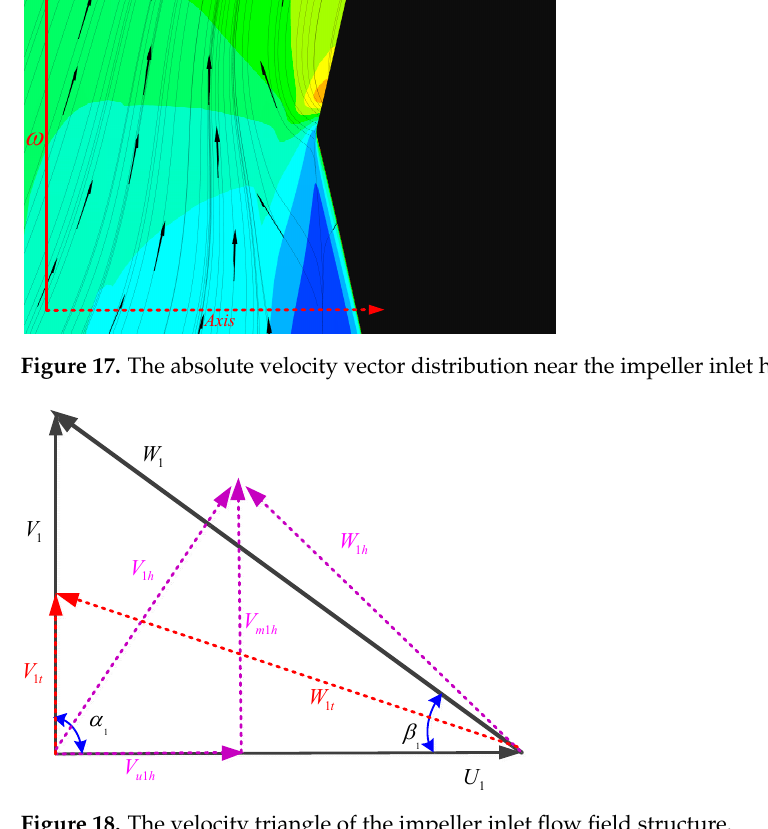
Figure 18. The velocity triangle of the impeller inlet flow field structure.